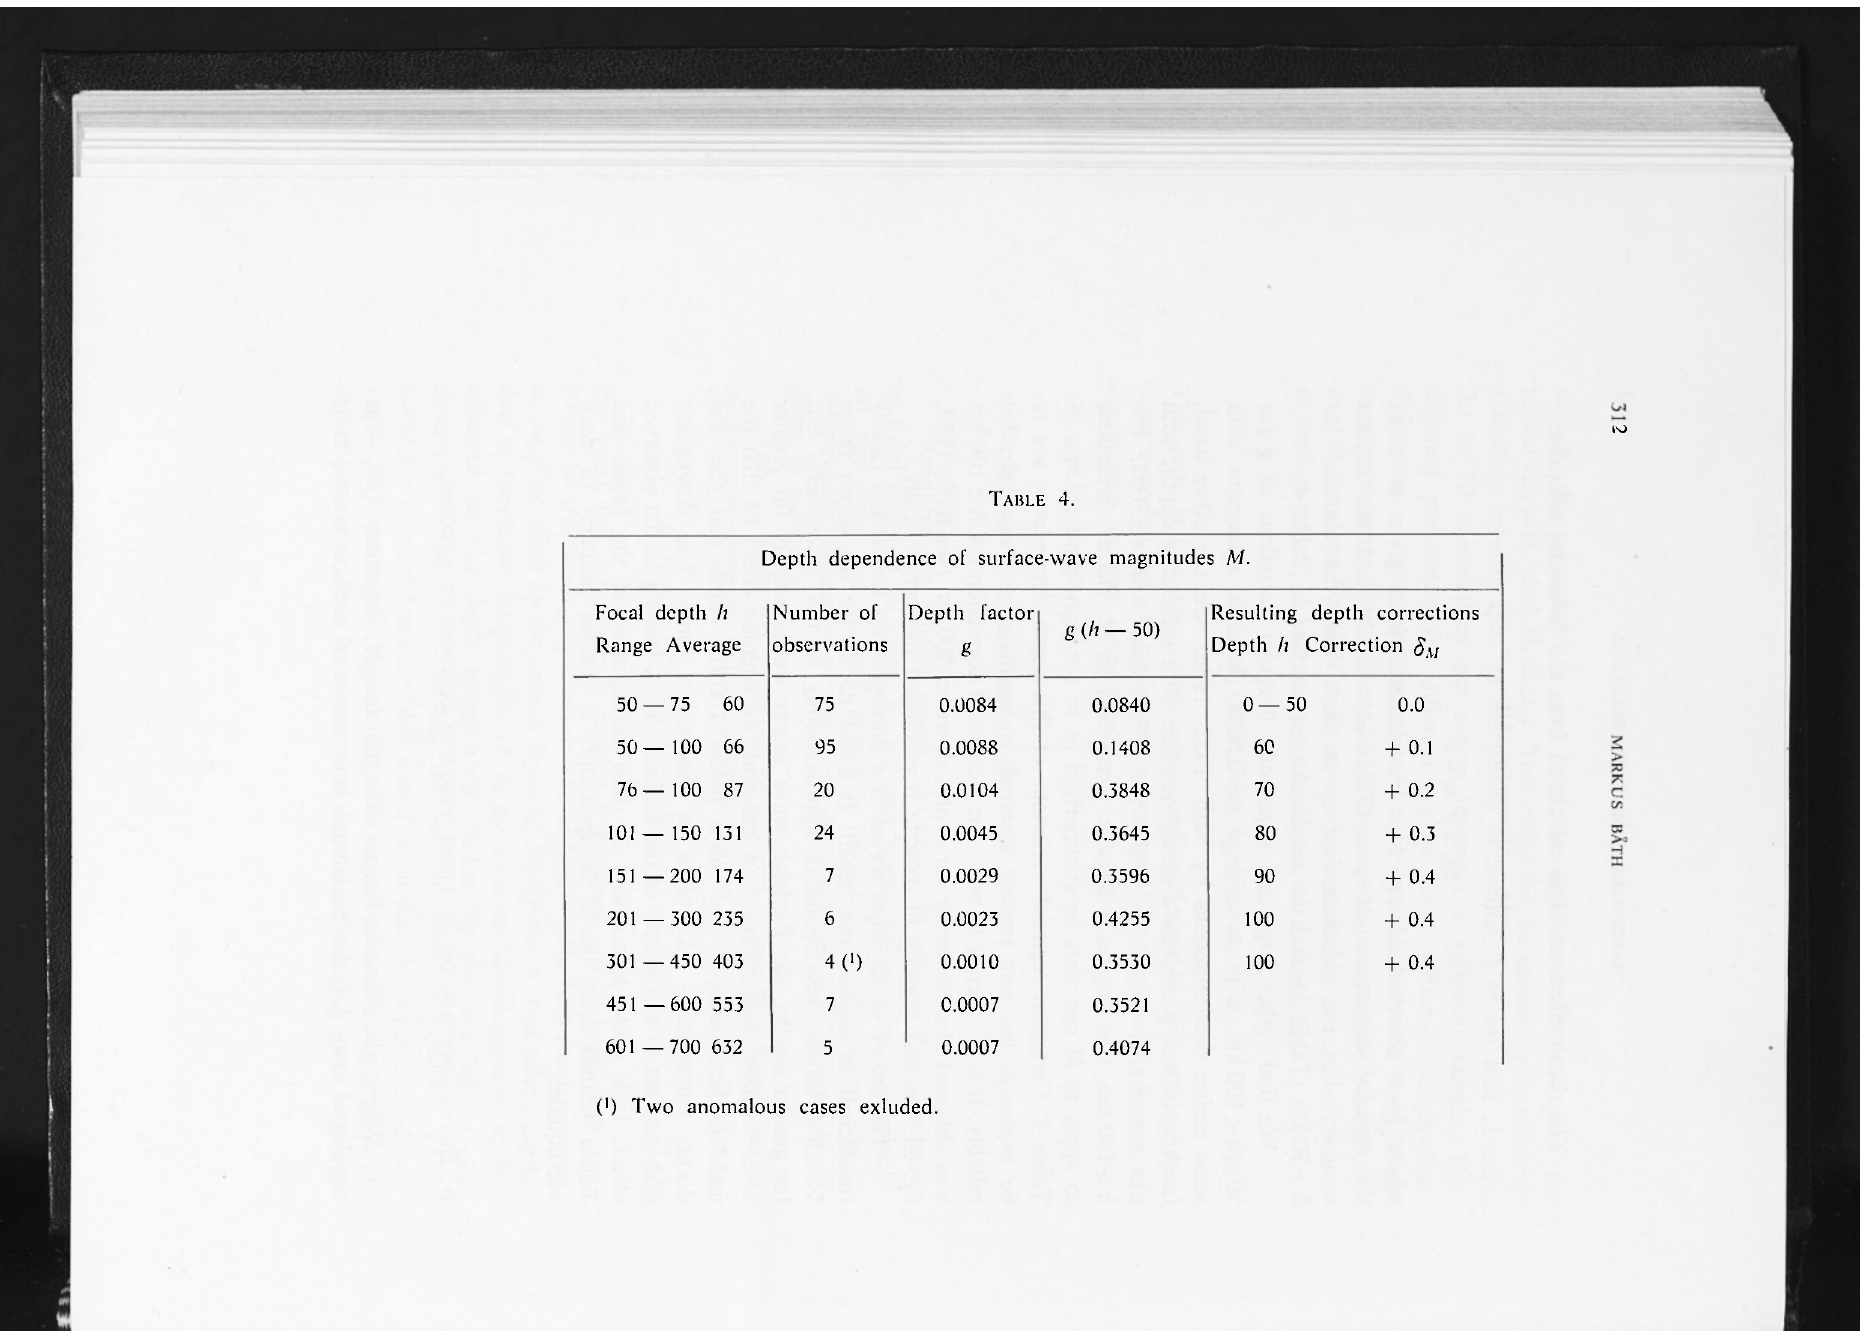
Depth dependence of surface-wave magnitudes